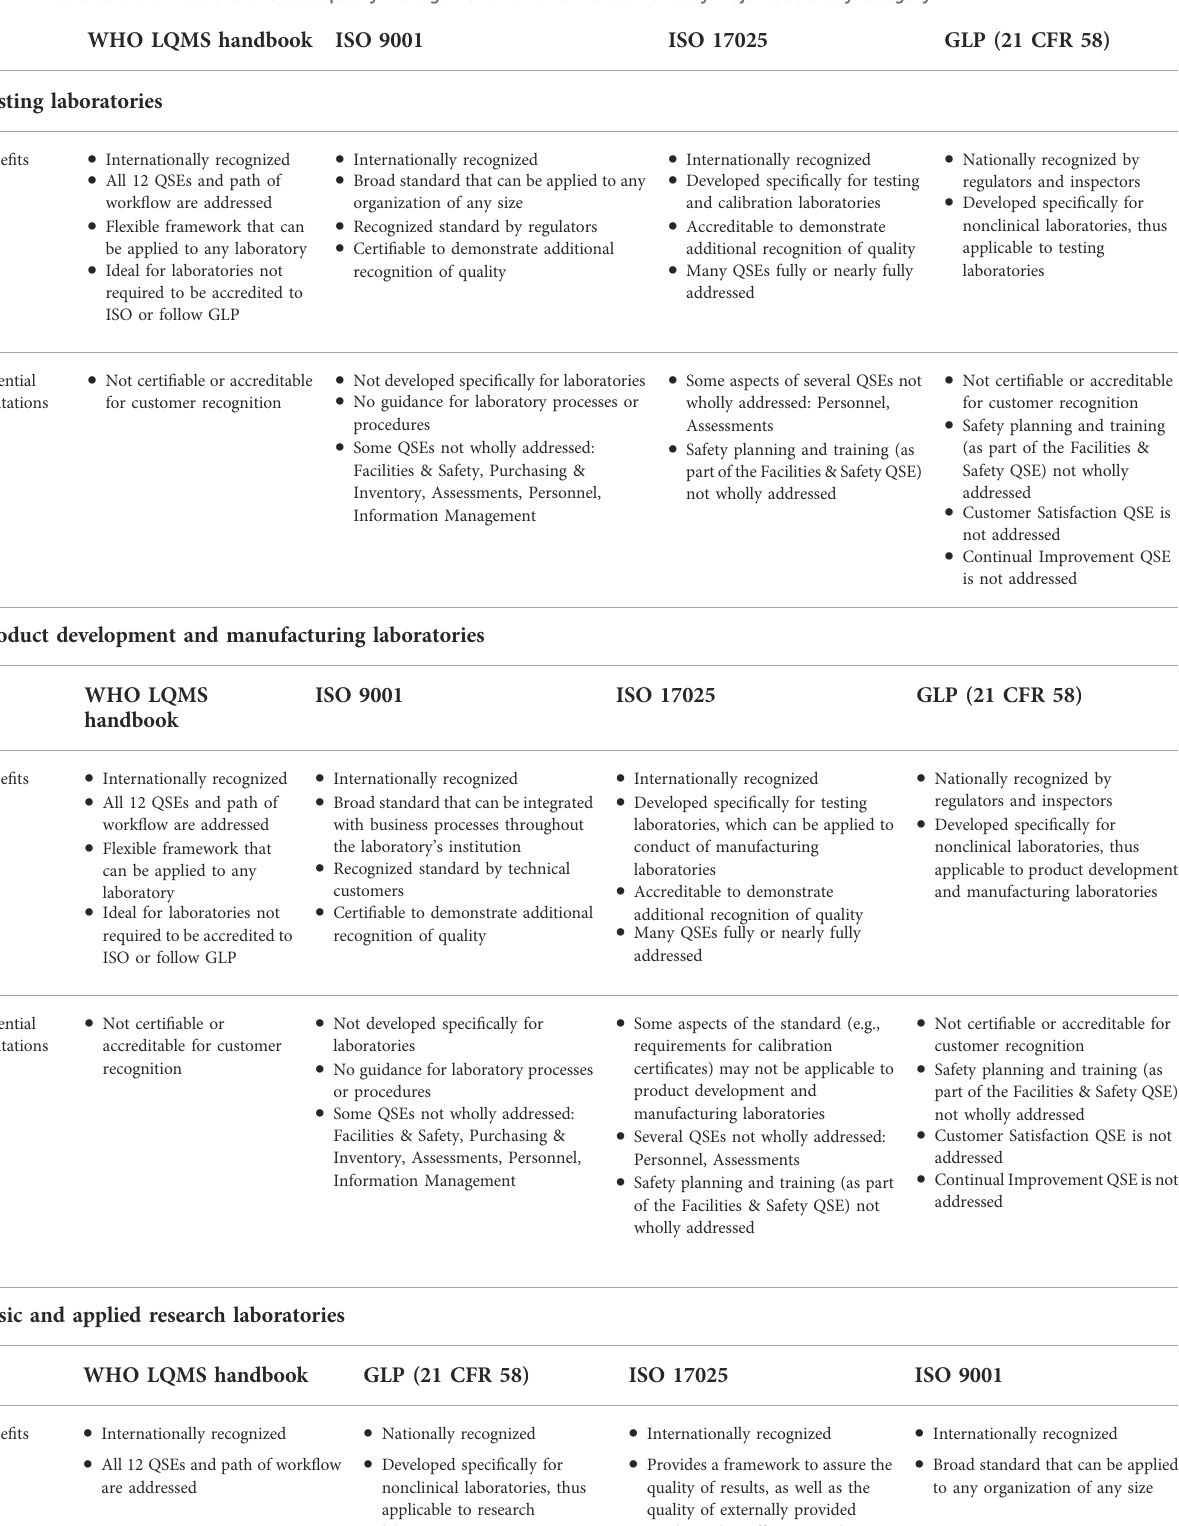
TABLE 2 Bene fi ts and limitations of select quality management framework documents by major laboratory